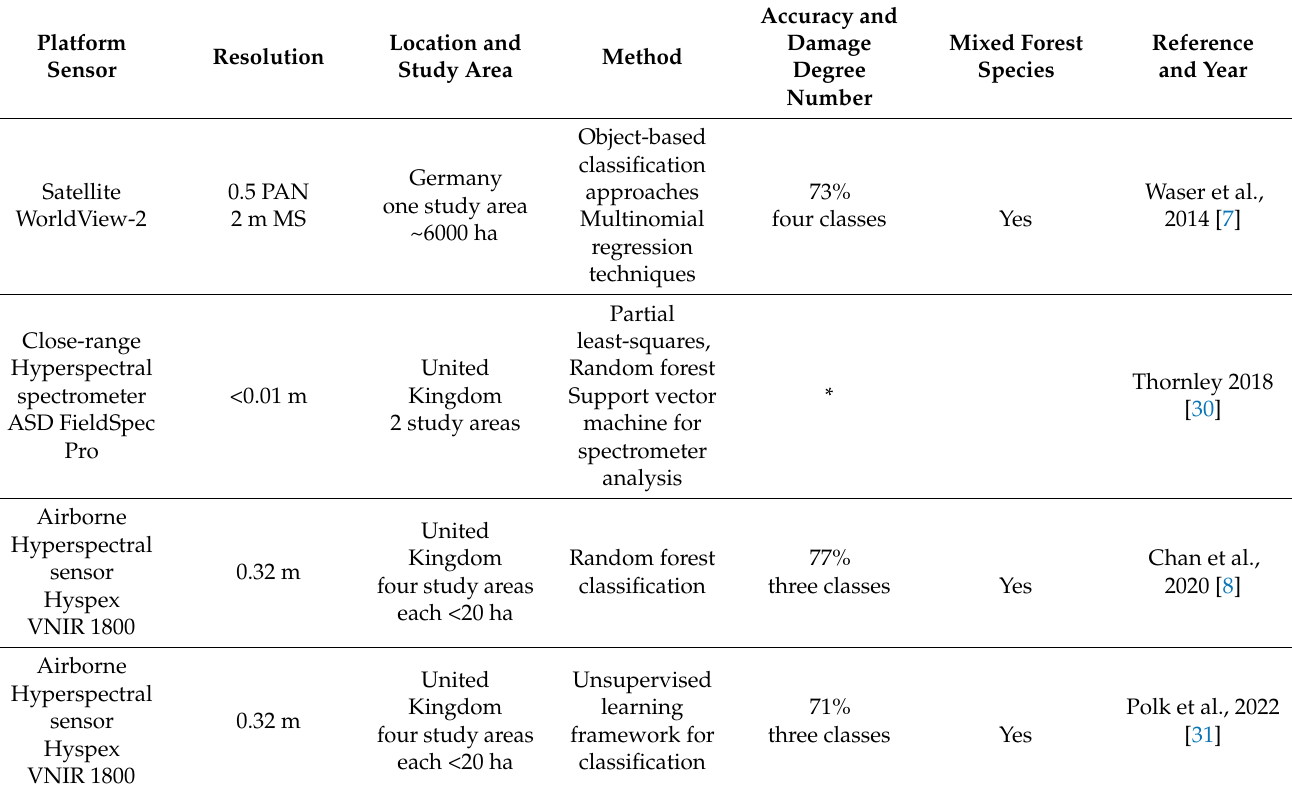
Table 1. Remote sensing methods for monitoring ash dieback published in previous